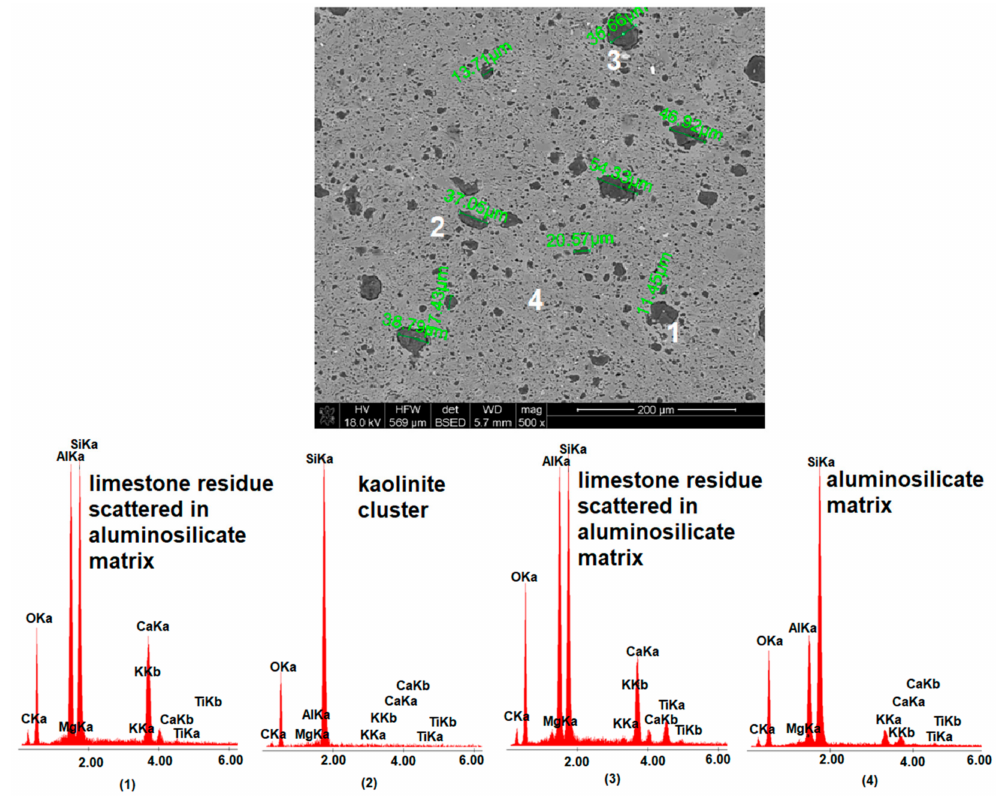
Figure 7. SEM-EDS image of MB4 material fired at 1160 ◦ C, including measurement of the size of pores resulting from the decomposition of calcium